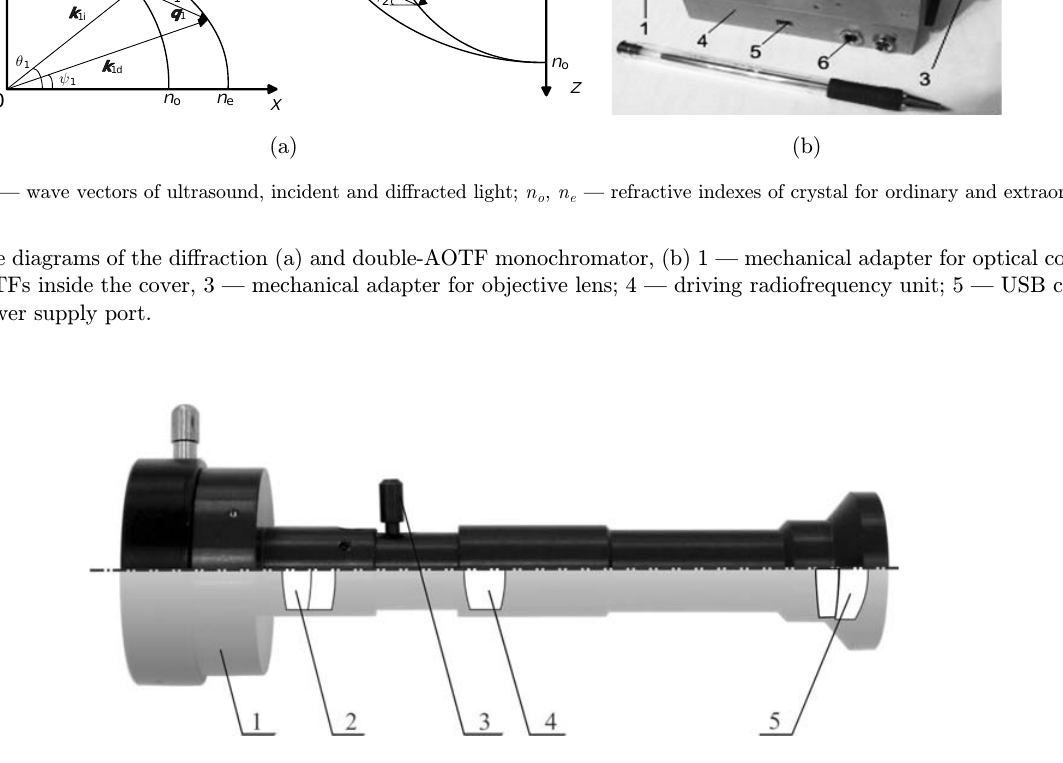
Fig. 2. Optical system of the coupler. 1 — mechanical adapter for endoscope ocular, 2, 4, 5 — lenses, 3 — focusing 2arctan(tan( ! AOTF Þ = (cid:1) ) and decreases the AOTF light beam diameter to the value (cid:1) D AOTF . Match-